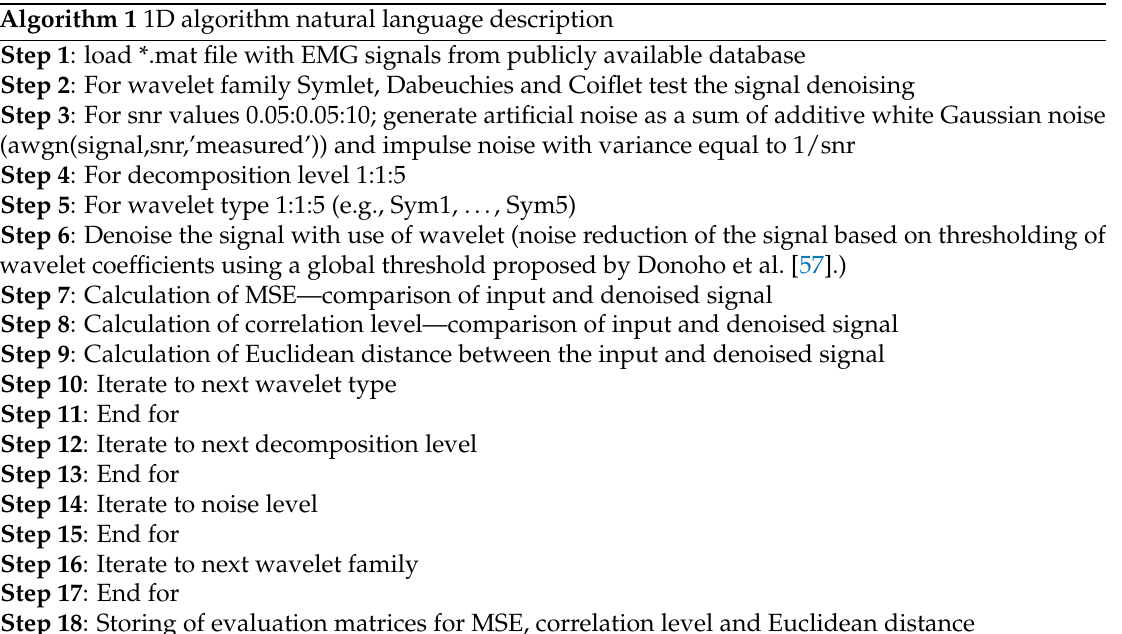
Algorithm 1 1D algorithm natural language